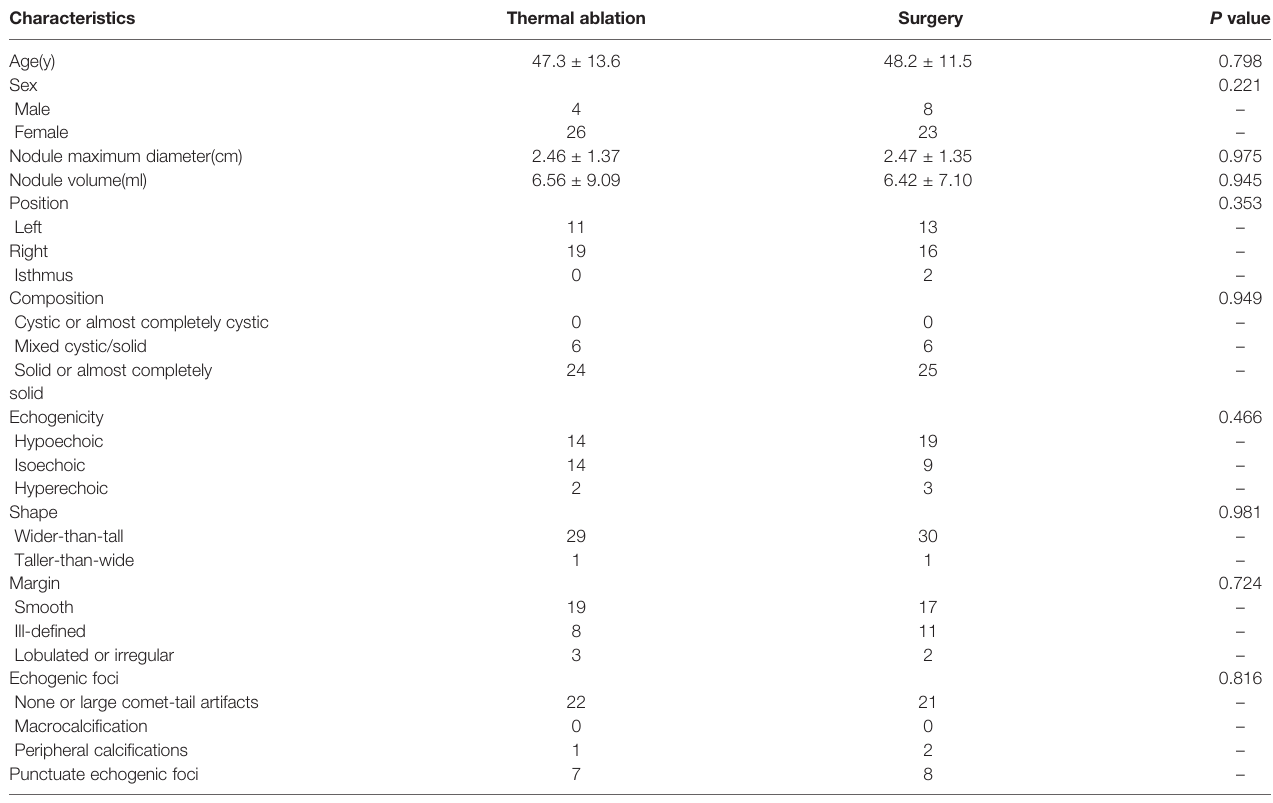
TABLE 1 | General information and ultrasound characteristics of patients undergoing thermal ablation and surgery.